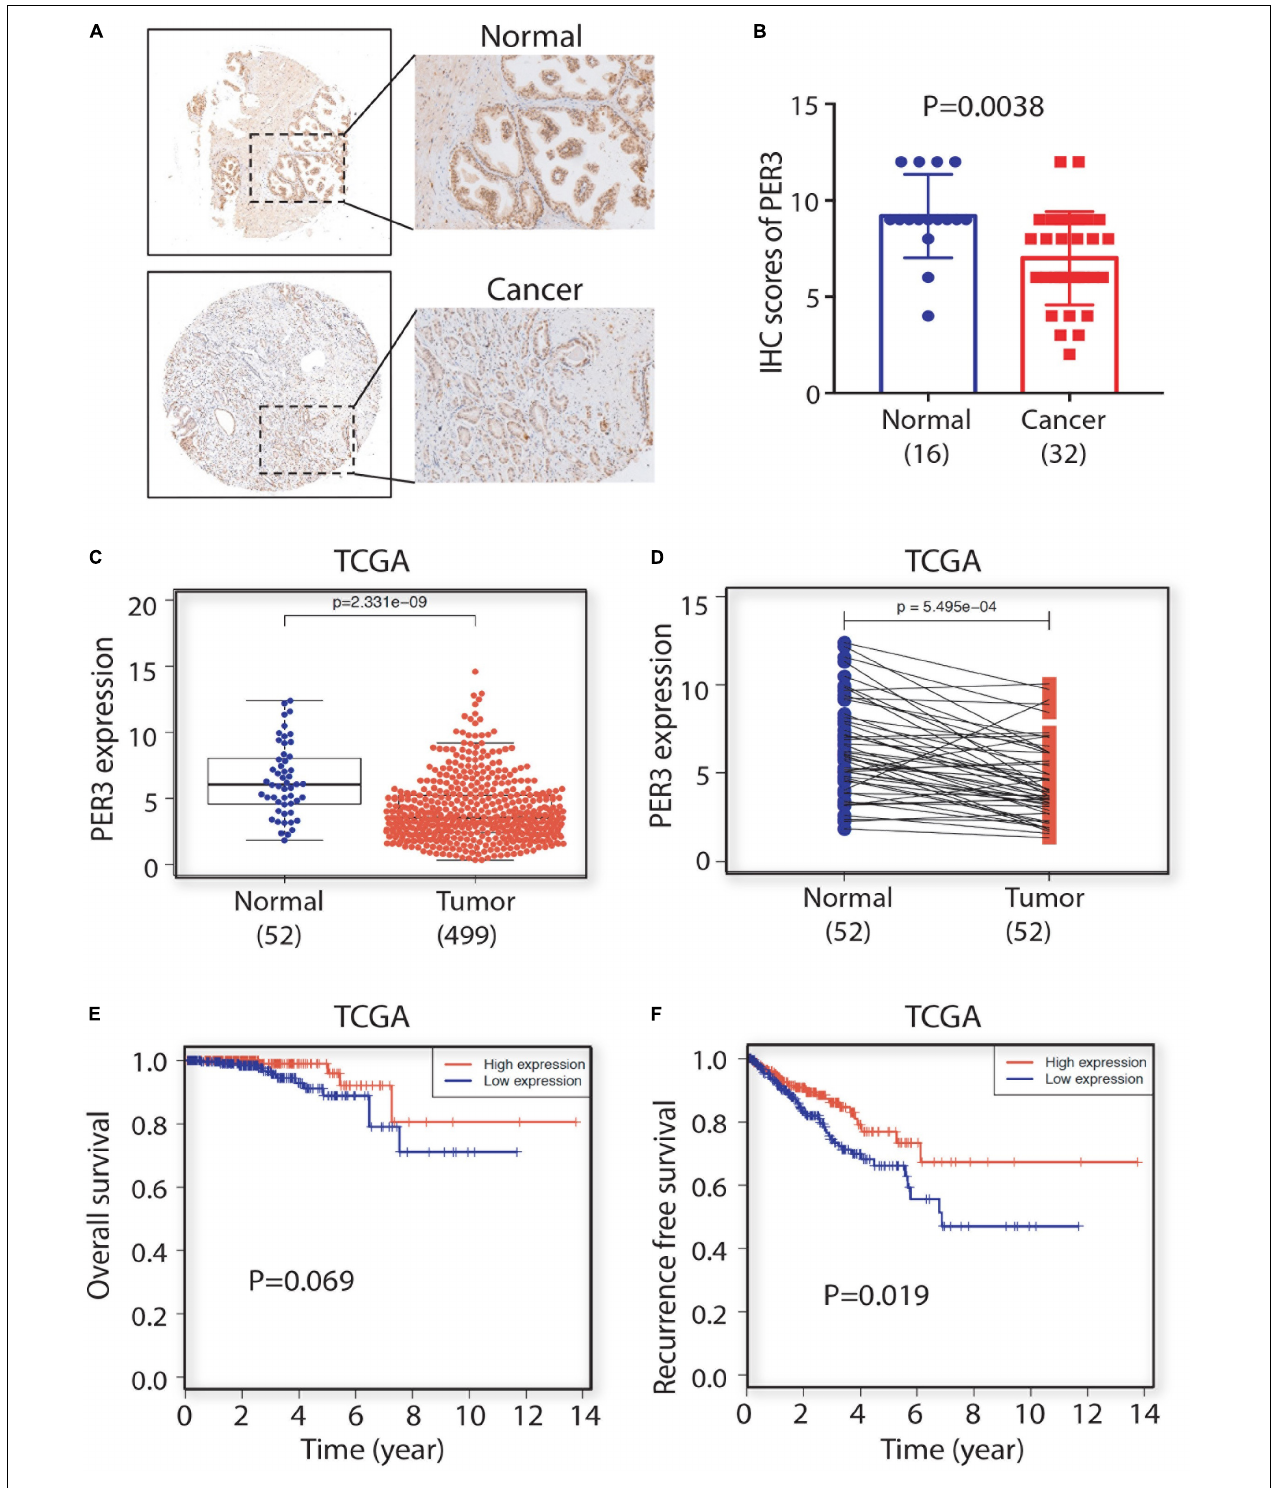
FIGURE 5 | PER3 is a potentially prognostic factor for prostate cancer. (A) Representative IHC images of PER3 expression in benign/normal prostatic tissues and prostate cancers. (B) Characterizations of PER3 from a tissue microarray (TMA, Pro-01019) containing 32 untreated PCa patient and 16 normal prostate tissue cores. (C) PER3 mRNA levels were downregulated in PCa in TCGA database. A total of 52 prostatic benign/normal and 499 prostate tumor tissues were compared (C) , and 52 matched normal and tumor pairs were compared (D) . (E,F) Kaplan-Meier analysis of the correlation of PER3 mRNA levels for overall survival rate (OS) and recurrence free survival rate in PCa patients from TCGA